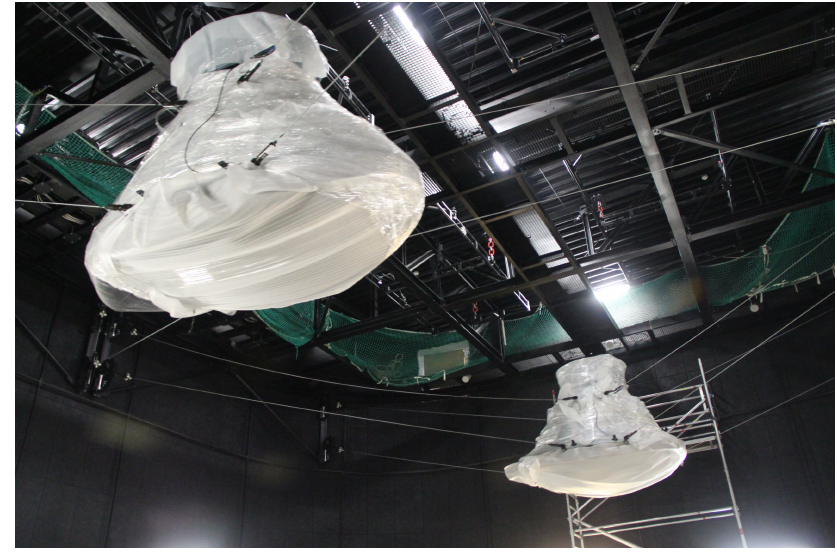
Figure 1. Cable robots in the transporting film during the commissioning at the German Pavilion at EXPO